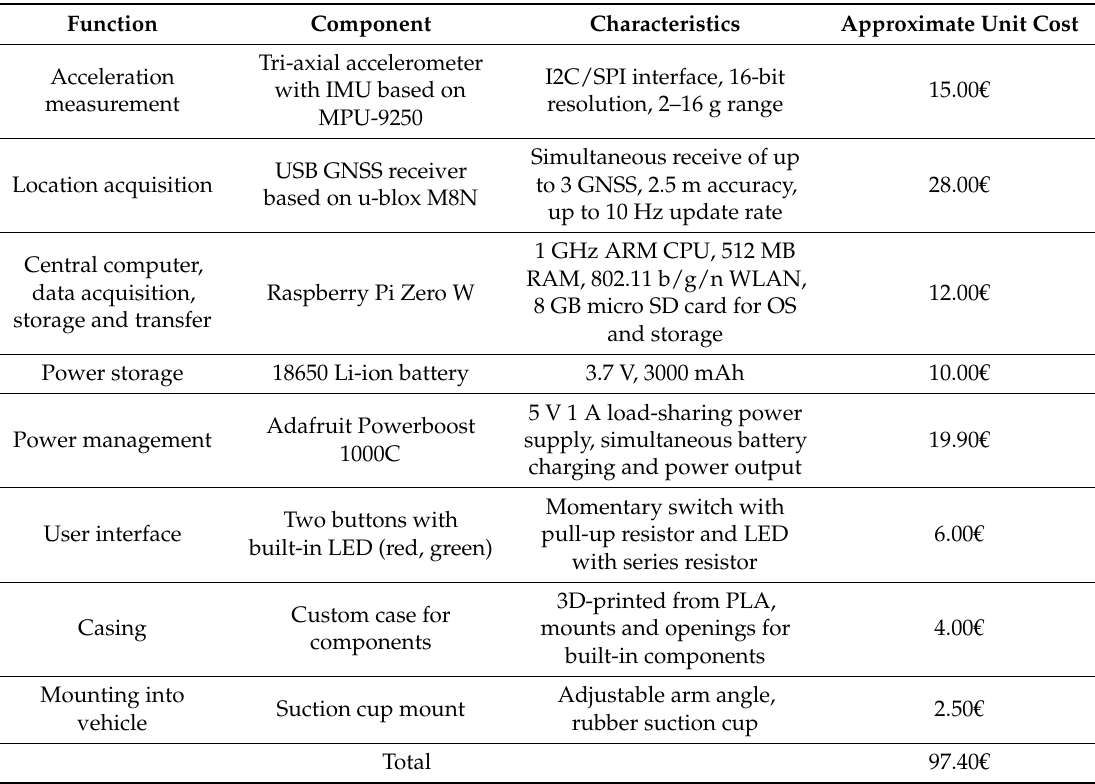
Table 2. Components selected for the